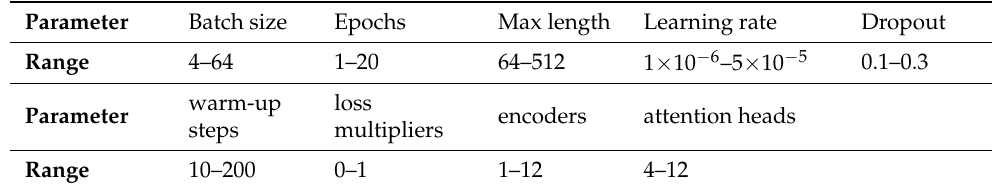
Table 5. Experimental parameters optimization search